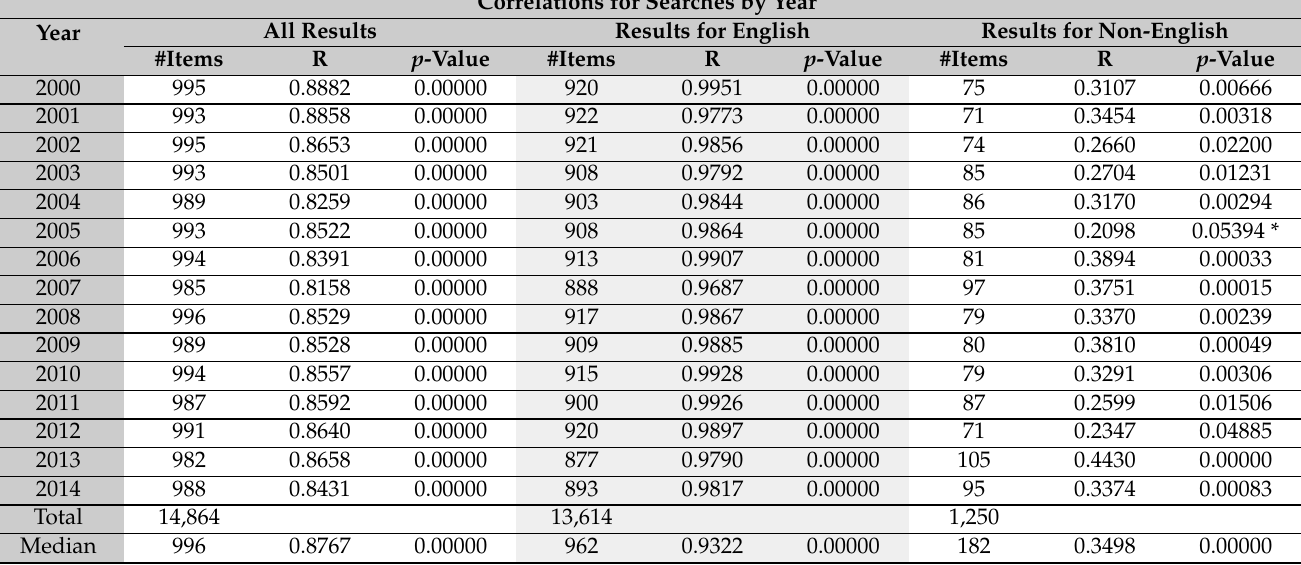
Table 6. Correlations between ranking by citations and the GS native ranking for searches by year.